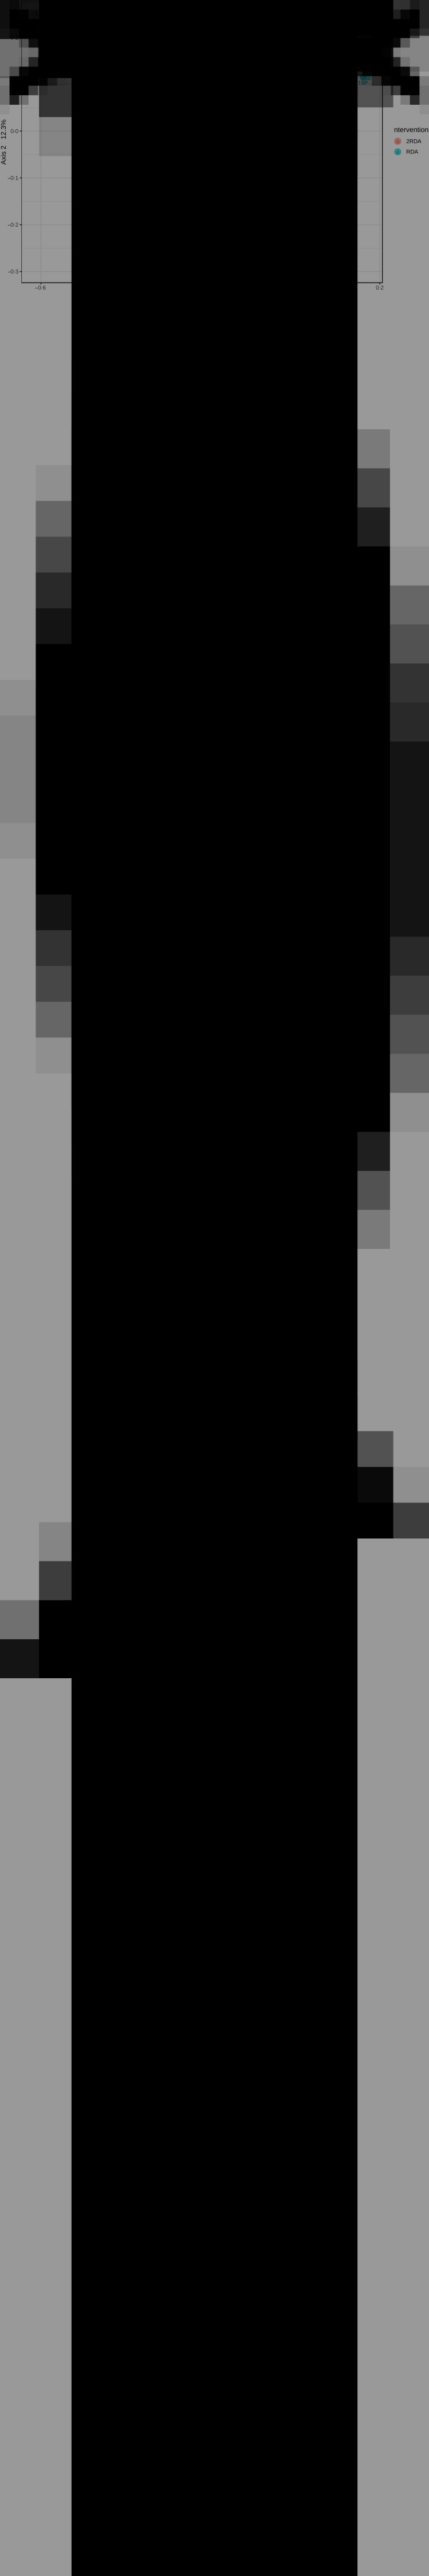
β-Diversity. RDA, diet containing the RDA of protein; 2RDA, diet containing twice the RDA of protein.